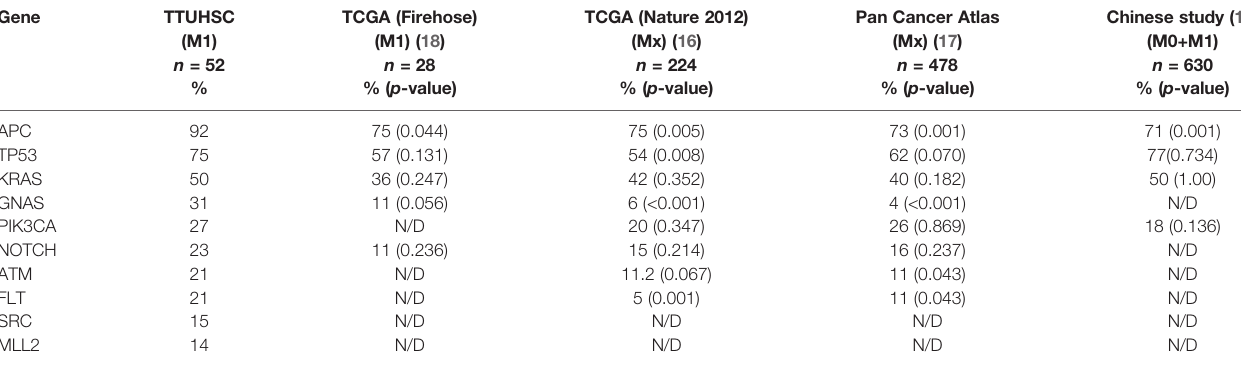
TABLE 2 | Prevalence of mutated genes in Hispanic patients with metastatic colorectal cancer in our study cohort compared to other